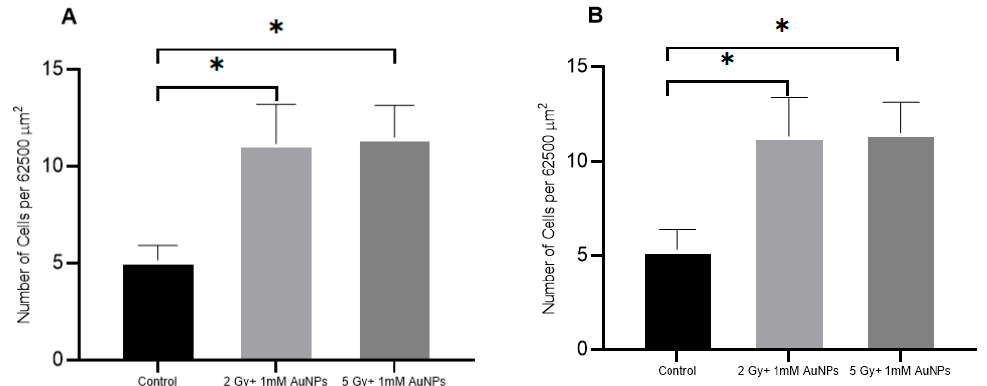
Figure 10. Effect of IR and/or AuNPs on the adhesion of human cancer cells in vitro. ( A ) DU145 (prostate) and ( B ) A549 (lung) cancer cells treated with 1 mM AuNPs 24 h prior to exposure to either 2 or 5 Gy (6 MV X-rays) and after 24 h the cells were trypsinised and plated in 6 well plates. After 4 h, the number of adhered cells in a 62,500 µ m2 area were counted. Results are expressed mean ± SEM of controls is shown as * p <